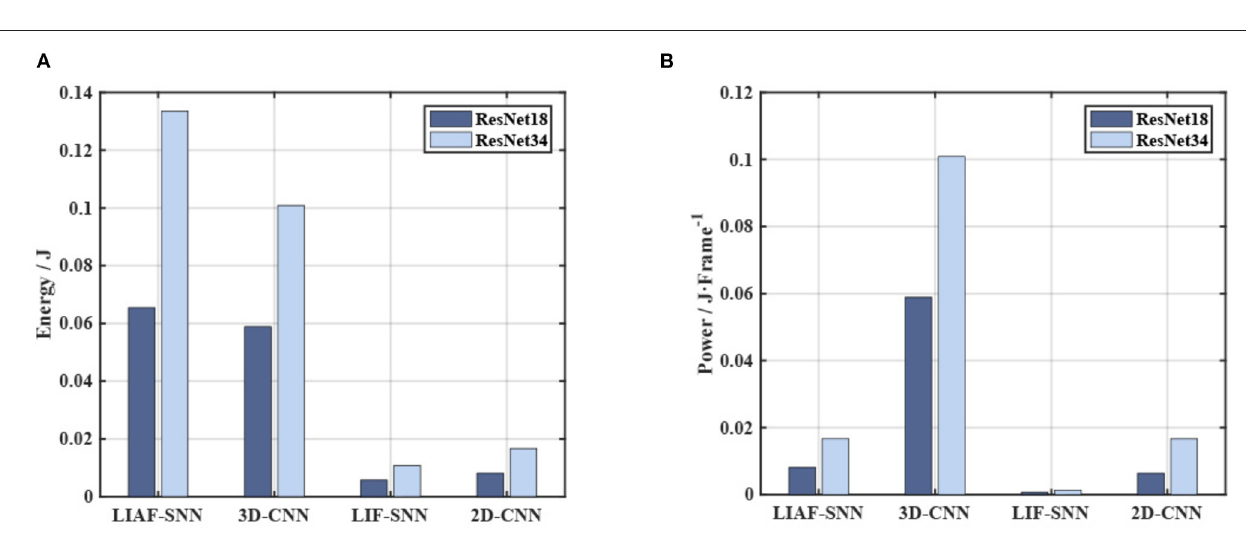
FIGURE 11 | Energy and power consumption in the experiments. (A) The comparison on energy cost. The LIF-SNNs have shown a significant advantage in energy consumption, whose energy cost is half of that of the CNN. (B) The power of each model in the Frame time unit is also the energy required for one feed-forward